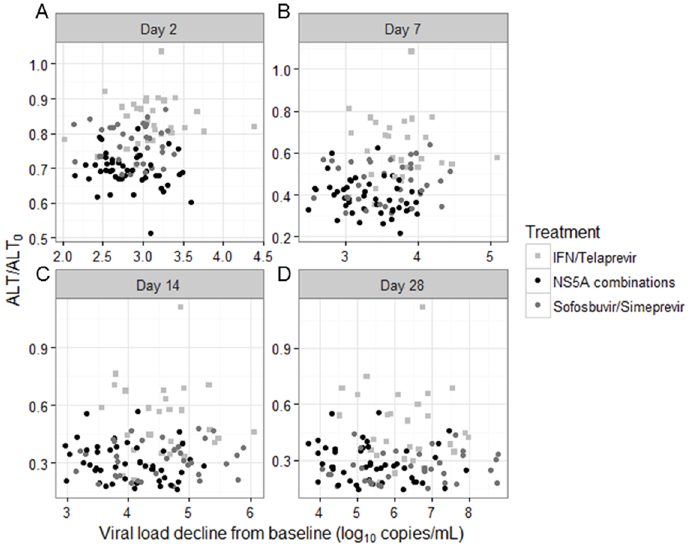
Fig 3. Decreaseof viral load and ALT at different time points under treatment according to NS5A- inhibitors and interferon administration. These graphs shows the median of predictions of ALT and HCV-RNA in different groups of treatment obtainedby simulations from the parameter estimates of the two models. ALT, alaninetransaminase; IFN, interferon.